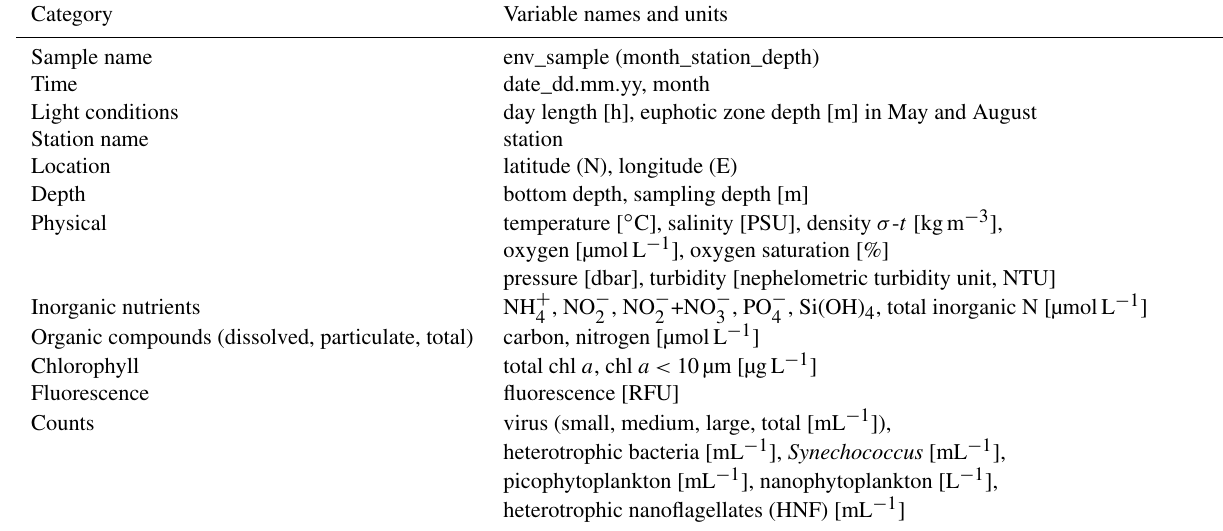
Table 1. Overview of the environmental data available from the water samples corresponding to the metabarcoding DNA samples presented in this paper, listed in the file “env_data_depths.txt” (see “Code and data availability” section). The original dataset can be found in Paulsen et al.